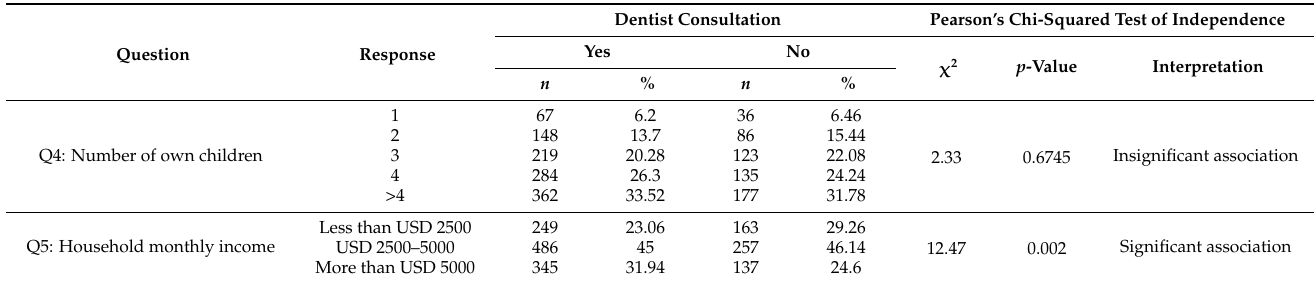
Table 3. Assessing the association between the demographic information and dentist consultation in children with perceived dental problems ( N =